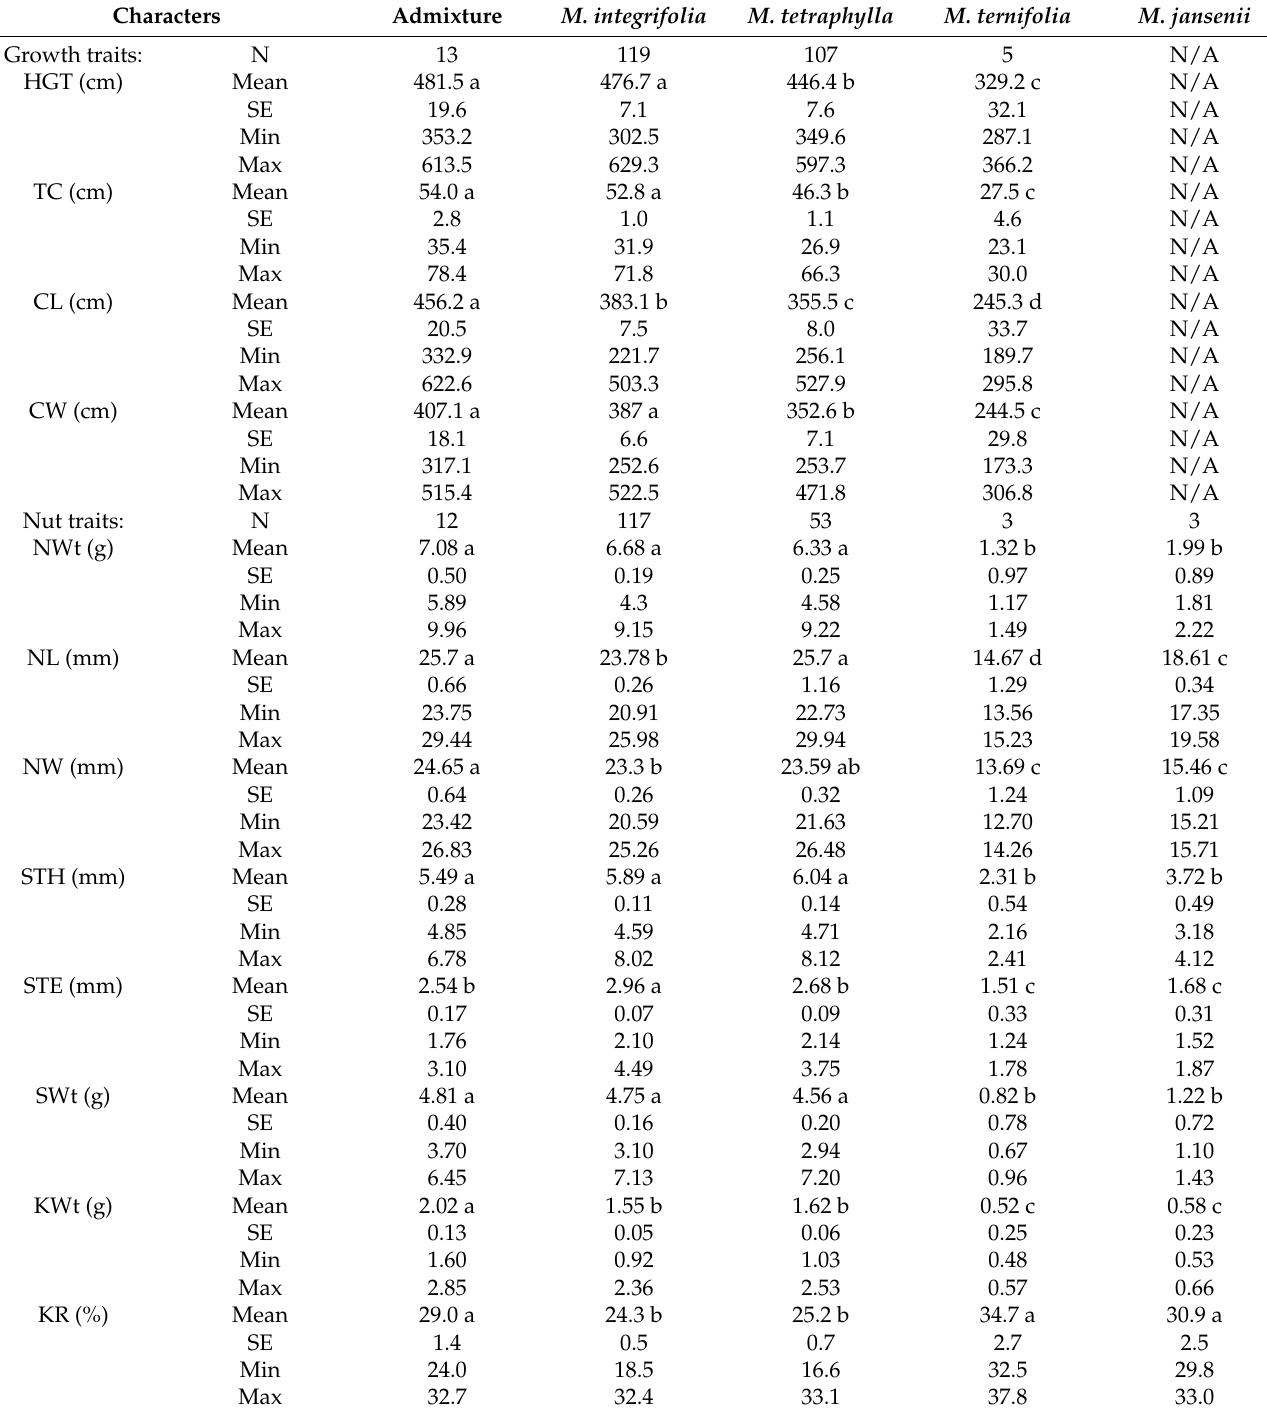
Table 1. Predicted species mean, standard error (SE), minimum, and maximum for tree height (HGT), trunk circumference (TC), canopy length (CL), canopy width (CW), nut weight (NWt), nut length (NL), nut width (NW), shell thickness at hilum (STH), shell thickness at equator (STE), shell weight (SWt), kernel weight (KWt), and kernel recovery (KR). Means within rows followed by the same letter are not significantly different based on z score between two means at p = 0.05. N: number of accessions. NA: not